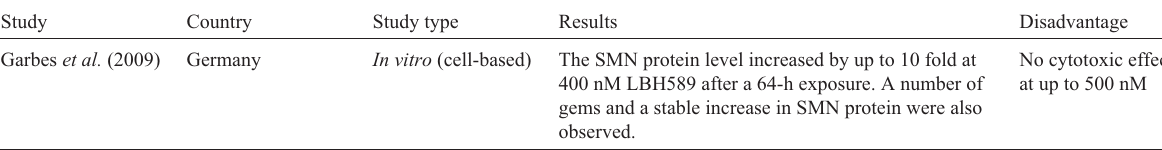
Table 5 - Summary of a study on LBH589for the treatment of spinal muscular atrophy.